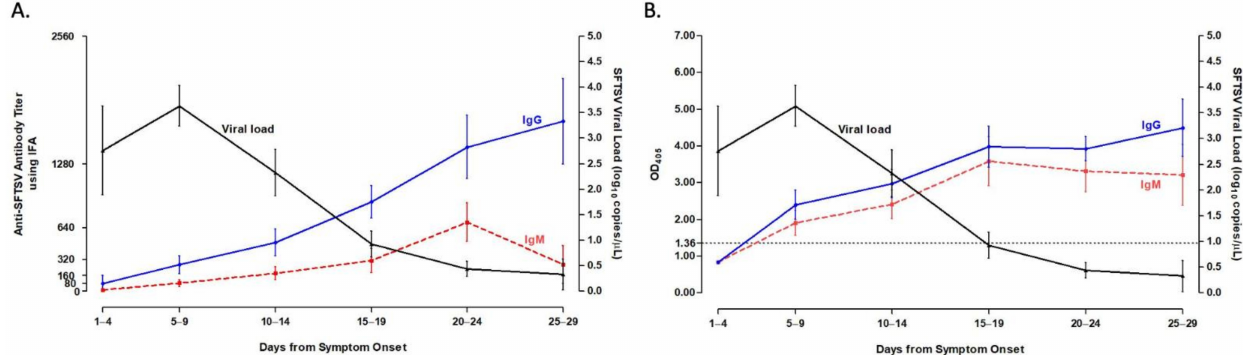
Figure 1. Kinetics of viremia and antibody responses in patients with SFTS. Data are denoted as means with standard error of mean (SEM). Both IgG and IgM were measured using IFA ( A ) and ELISA ( B